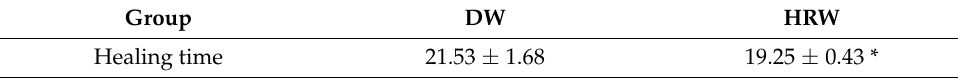
Table 3. The wound healing time (d) in DW and HRW groups. * p < 0.05. Group DW HRW Healing